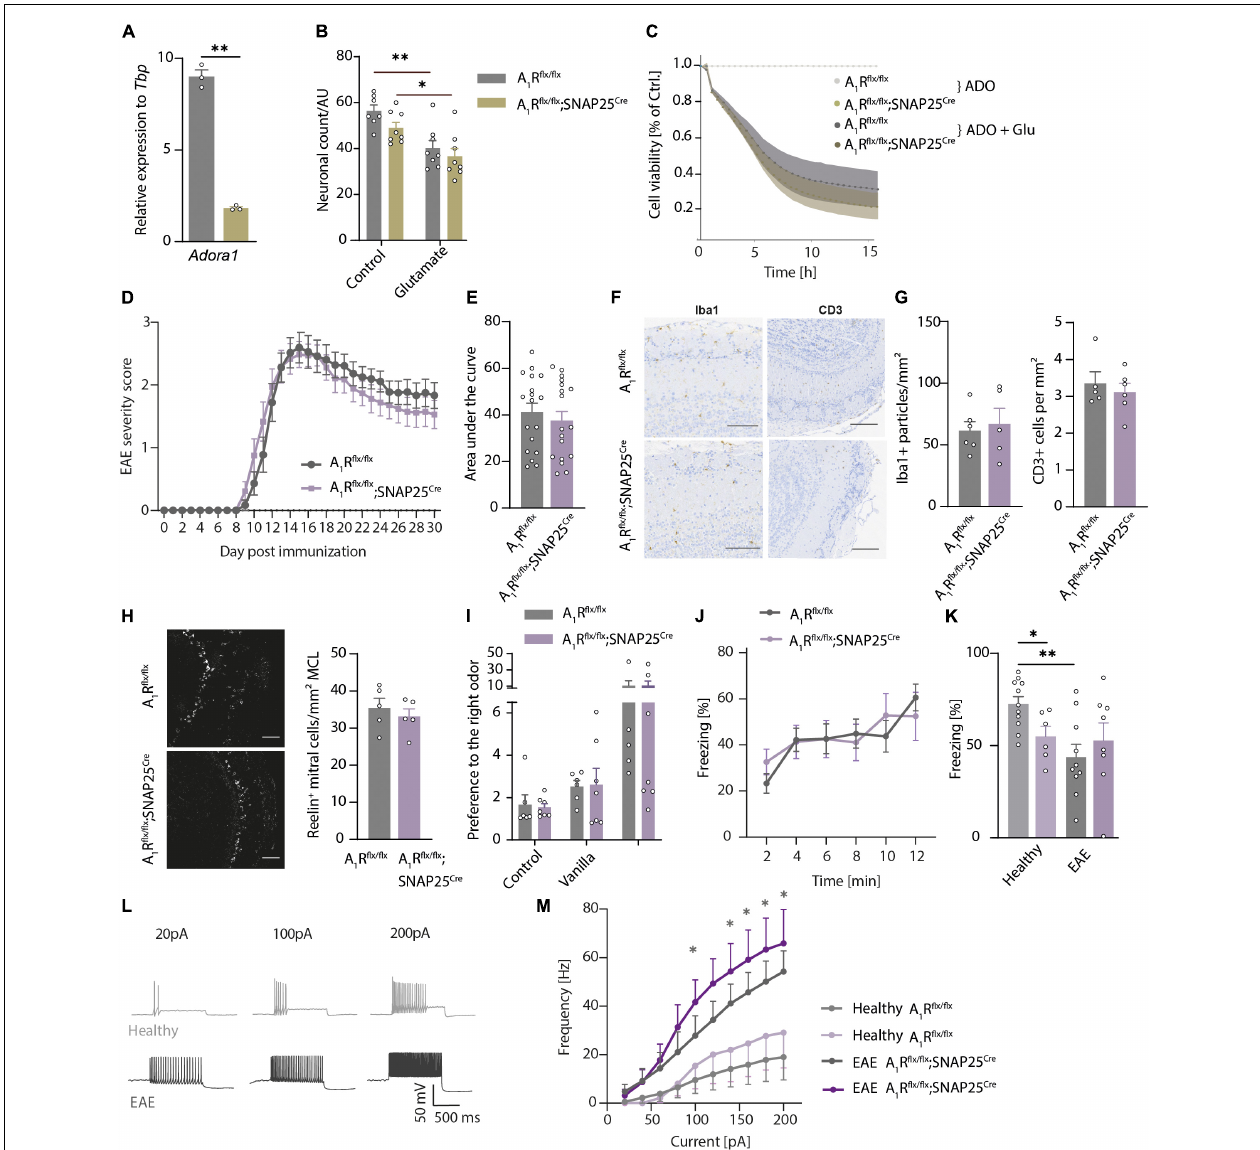
FIGURE 4 | Neuroinflammation results in olfactory dysfunction and hyperexcitability that is not influenced by neuronal A 1 R. (A) Adora1 expression in primary neuronal cultures of olfactory bulb neurons DIV 14–16 of A 1 R flx / flx (gray) and A 1 R flx / flx ;SNAP25 Cre (beige) ( n = 3 per group). (B) Neuronal survival in vitro measured by MAP2-positive cells after treatment with 5 µ M of glutamate for 6 h in A 1 R flx / flx and A 1 R flx / flx ;SNAP25 Cre ( n = 3 biological replicates with 2–3 technical replicates). (C) Luminescence-based measurement of cell viability over 15 h treated with 10 µ M of adenosine (ADO) and 5 µ M of glutamate or medium as control ( n = 4 biological replicates per group with at least 5 technical replicates each). (D) Clinical time course of experimental autoimmune encephalomyelitis (EAE) over 30 days ( n = 18 per group) in A 1 R-proficient (A 1 R flx / flx ) and A 1 R-deficient (A 1 R flx / flx ;SNAP25 Cre ) mice. (E) Disease severity in EAE analyzed by area under the curve (BF 10 = 0.384). (F) Representative images and (G) quantification of microglia activation measured by Iba1 (BF 10 = 0.506), and T-cell infiltration evaluated by CD3-positive cells/mm 2 (BF 10 = 0.476) in the main olfactory bulb in coronal slices ( n = 5 per group). (H) Reelin-positive mitral cells per mm mitral cell layer at day 30 post-immunization (p.i.) ( n = 5 per group, BF 10 = 0.673). (I) Olfactory detection test at the early phase of EAE (day 10–12 p.i.) in A 1 R flx / flx n = 6 and A 1 R flx / flx SNAP25 Cre n = 7. As mice were exposed to odors at two sides of the cage (first trial empty control, second trial vanilla on the right side, third trial almond on the left side where vanilla was reintroduced on the right side), preference to one side of the cage has been measured by means of the ratio between the sides. (J) TMT-based olfactory testing measured by the percentage of freezing in bins of 2 min in EAE (A 1 R flx / flx n = 10 and A 1 R flx / flx ;SNAP25 Cre n = 8). (K) TMT-based olfactory behavioral test in healthy animals and at the early phase of EAE. Percentage of freezing after 10 min in A 1 R flx / flx (healthy n = 11 in light gray, EAE n = 10 in gray) and A 1 R flx / flx ;SNAP25 Cre mice (healthy n = 6 in light lavender, EAE n = 8 in lavender). (L) Representative traces of mitral cell action potentials in healthy control (light gray) and acute phase of EAE (dark gray). (M) Increase of frequency of action potentials of mitral cells depending on the injected current in healthy ( n = 7) and acute EAE ( n = 5) slice preparations of A 1 R flx / flx (healthy n = 7; EAE n = 5) and A 1 R flx / flx ;SNAP25 Cre (healthy n = 5; EAE n = 7) mice, analyzed by Mann–Whitney U -test. Statistical analysis was performed by two-way ANOVA in repetitive measurements (C,D,J,L,M) and unpaired t -test, if not stated otherwise; ∗ P < 0.05, ∗∗ P <